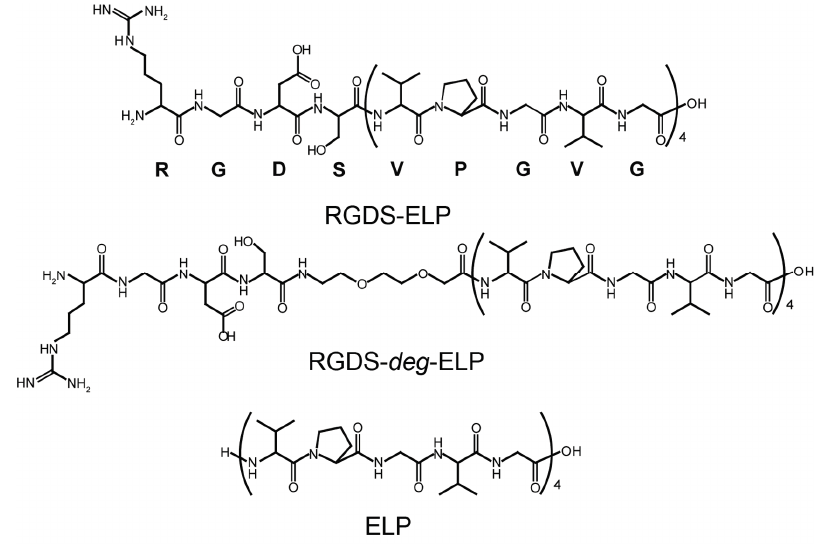
Figure 1. Primary structures of the thermo-responsive elastin-like oligopeptides containing cell-binding RGDS epitope (RGDS-ELP, RGDS- deg -ELP) used as building units for self-assembled molecular layers. V: valine, P: proline, G: glycine, R: arginine, D: aspartic acid, S: serine.